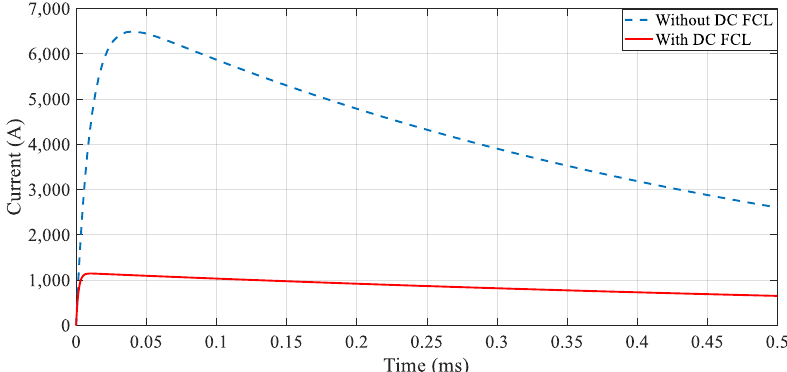
Figure 10. Impact of the DC FCL on the fault current.